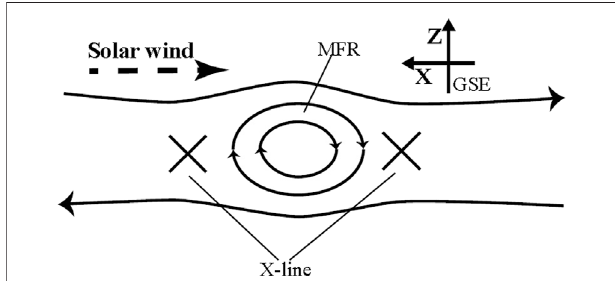
FIGURE 1 | An illustration of a magnetic fl ux rope (MFR) formed by multiple X-line magnetic reconnection. The dashed arrowed line indicates the direction of the movement of the solar